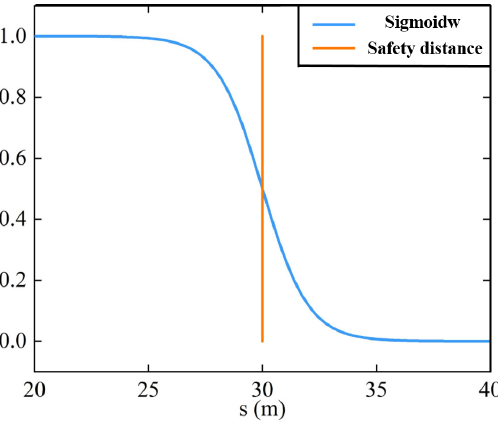
Figure 7. Sigmoid